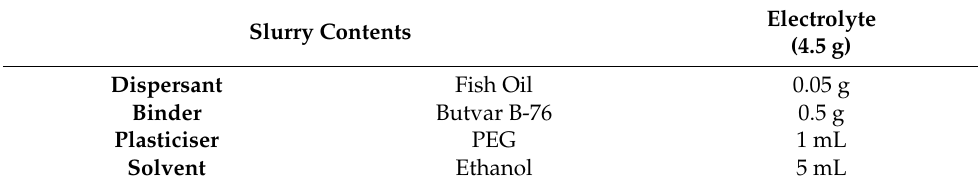
Figure 1. The step-wise procedure for the electrolyte powder synthesis and electrolyte layer prepa- ration via tape casting process. Table 1. Additive ratios of tape casting